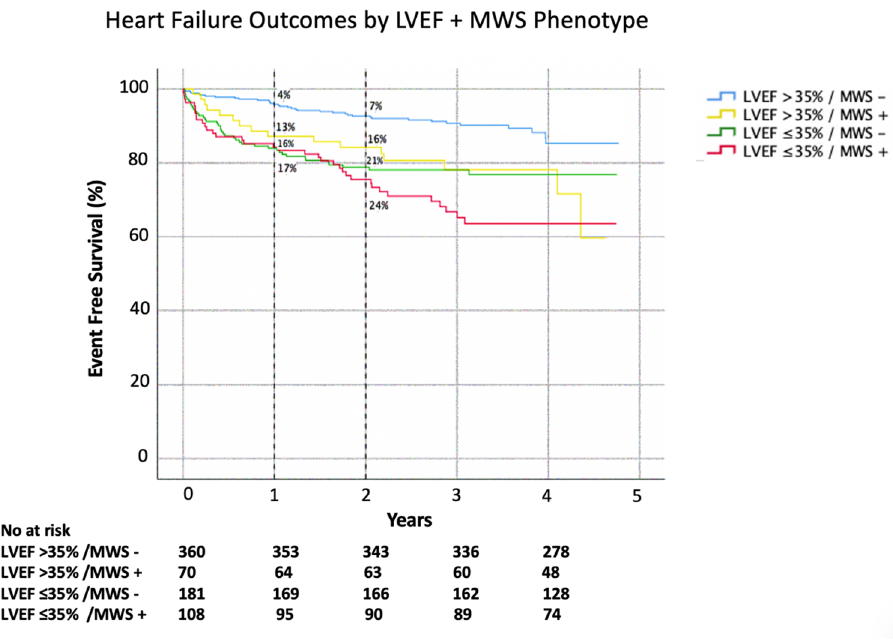
Figure 6. Kaplan–Meier event free survival curve for the secondary heart failure outcome of HF admission, left ventricular assist device (LVAD) implantation, cardiac transplantation or all-cause mortality stratified by the combined presence or absence of mid-wall striae (MWS) fibrosis and LVEF ≤ 35%.